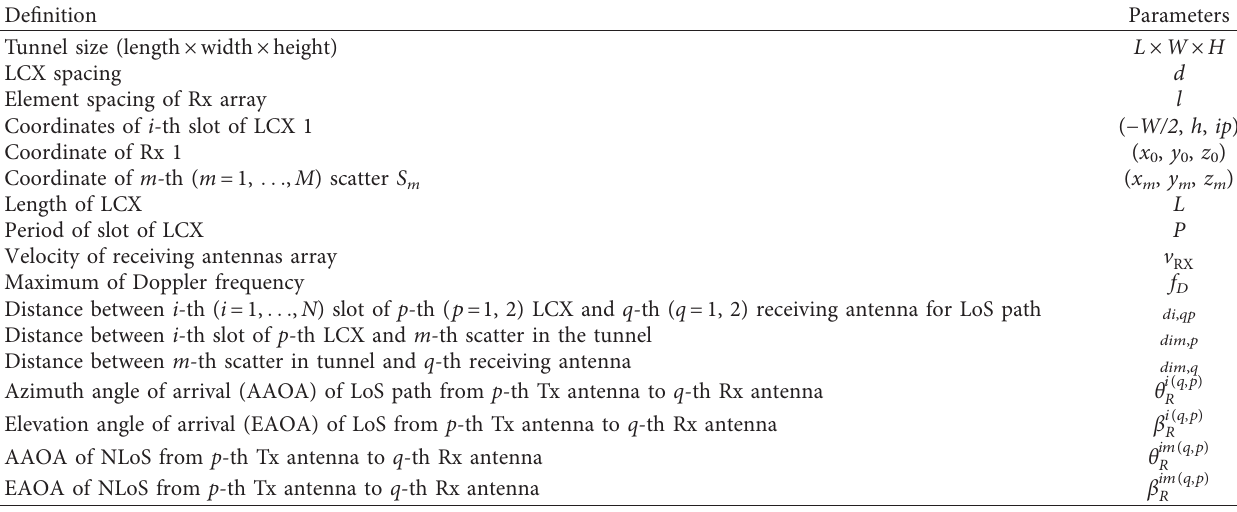
Table 1: Definition of LCX-MIMO model